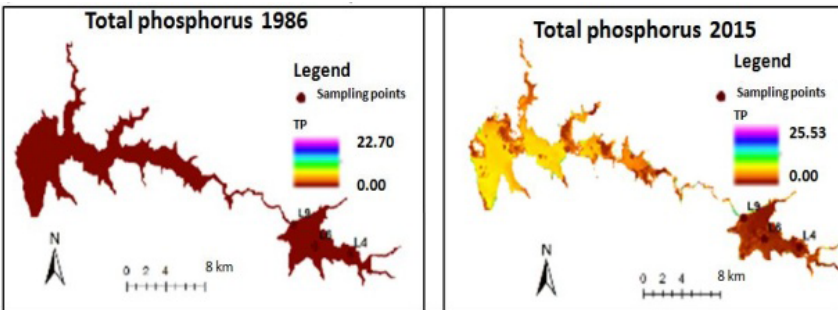
Figure 4. Spatial variations of Total Phosphorus 1986 and 2015.